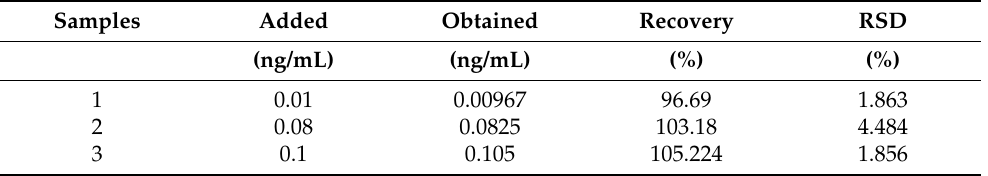
Table 2. Determination of AFP in the serum ( n =